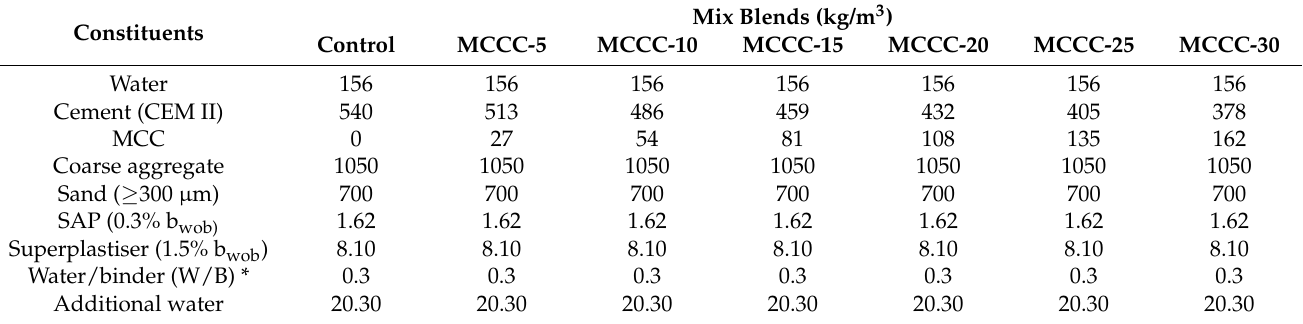
Table 1. Mix constituents of HPC with